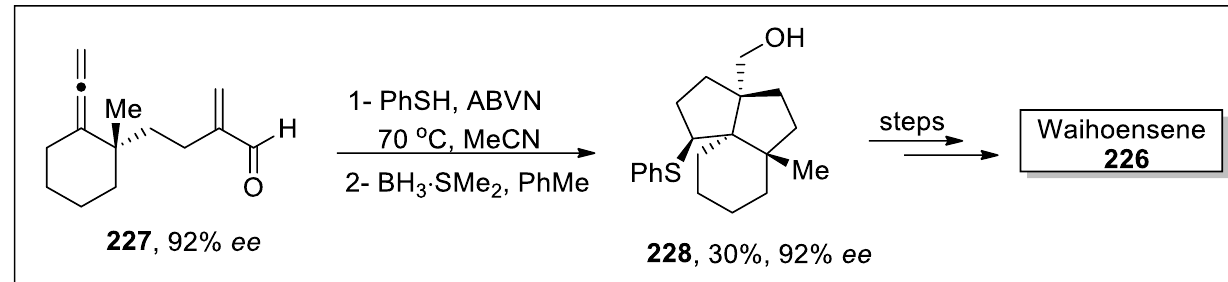
Scheme 58. Synthesis of triquinane 226 via intramolecular [3+2] cycloaddition